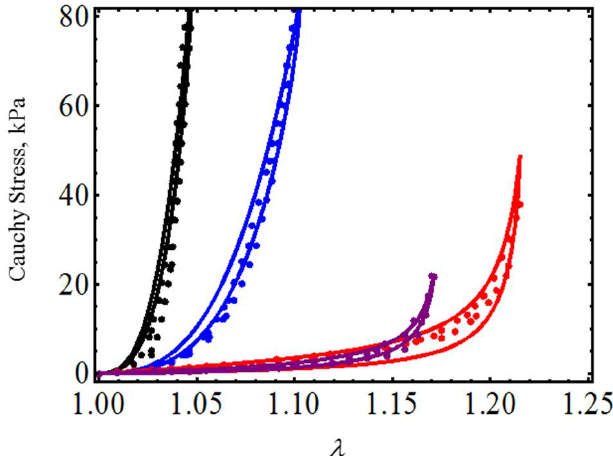
Figure 6. Cauchy stress-stretch data for specimens of the mucosa and submucosa human tracheal membrane. The material parameter values used to obtain the theoretical predictions are summarized in Table 2. Here, the solid black, blue, purple and red lines represent theoretical predictions, while the color dots describe the experimental data obtained from the CAM, CSM, ASM, and AAM mucosa and submucosa membranes. The experimental data were adapted from